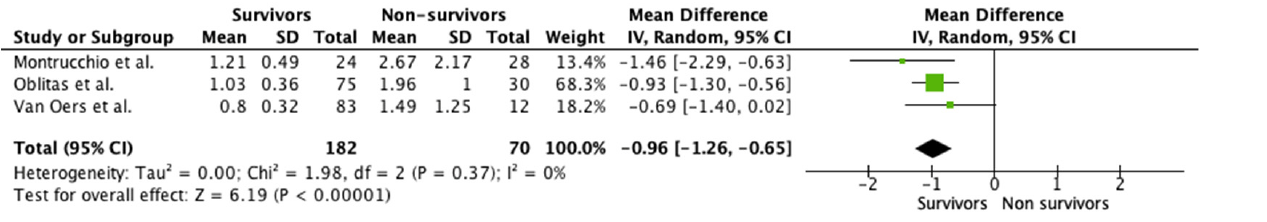
Figure 2. Forest plot of the hypothetical meta-analyzed results [14,28,33]. One of the four studies selected could not be included as it did not report the standard deviation. Analysis conducted with Review manager 5.4 [11].